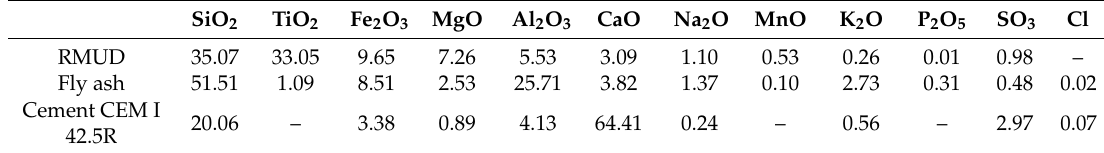
Table 1. Concentration [%] of main constituents in RMUD, fly ash and